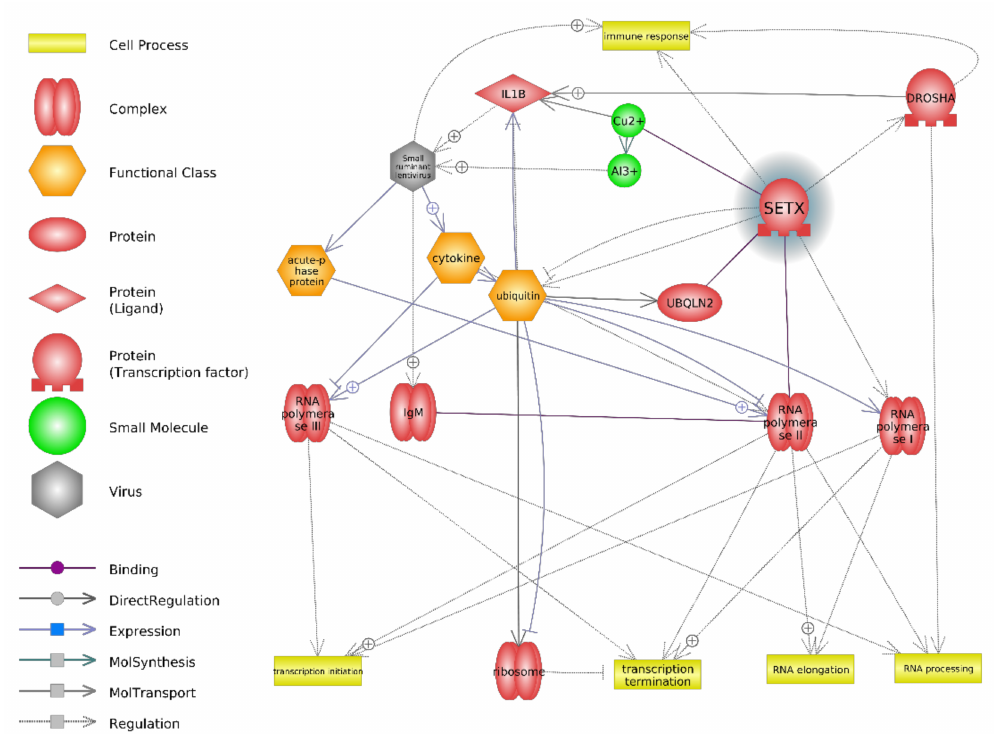
Figure 4. Interactions between proteins, cell process, and lentiviral infection for the protein product of the SETX gene in PBNCs. DROSHA—gene encoding a ribonuclease (RNase) III double-stranded RNA-specific ribonuclease. IL1B— interleukin 1 β ; IgM—Immunoglobulin M.